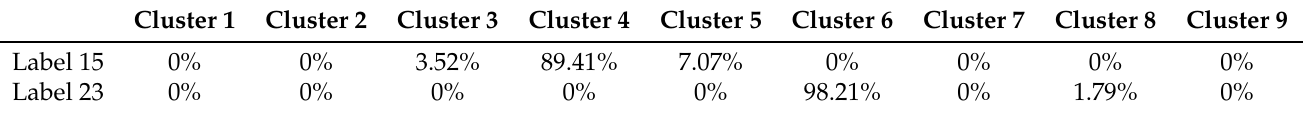
Table 5. Uneven distribution of hyper-labels.